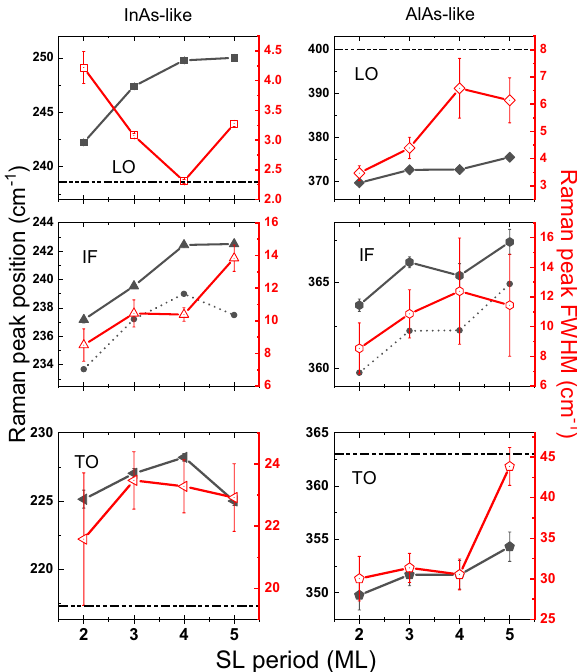
Figure 3. Peak positions and FWHMs of LO, IF, and TO phonon modes with error bars obtained from the fitting results concerning the periods. The horizontal dashed lines indicate the phonon frequencies for bulk InAs and bulk AlAs. The scatters connected by dashed lines in IF modes indicate the mid-position of LO and TO